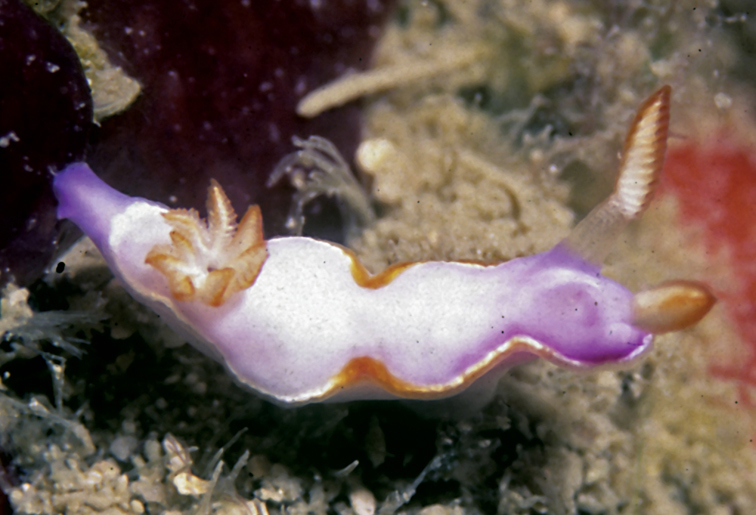
Thorunna cf. horologia, 5 mm pres., Sri Lanka, RC Anderson.